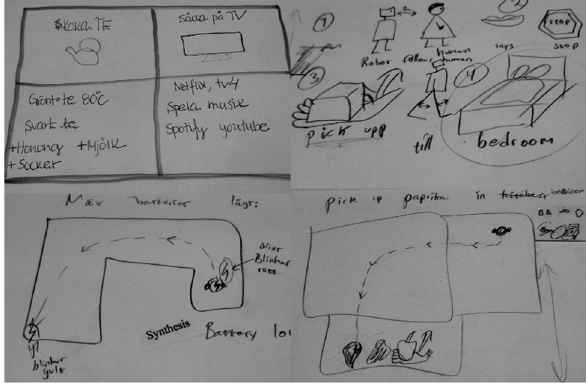
Figure 8: Four examples of sketched designs made by participants. From left to right, top to bottom: a menu system on the display with di ff erent actions, the robot could help the user with ( e.g. turn on the TV ) , together with sub - categories ( e.g. Net fl ix, YouTube ) . A picto - graph system where the robot shows pictures on the display of the sub - tasks in a task that it plans to perform. A map system on the display that shows the robot ’ s position and goal, here with the use of the label voice synthesis. A combination of a map system on the display with the robots position and goal, and pictographs at the bottom of what the robots ’ mission